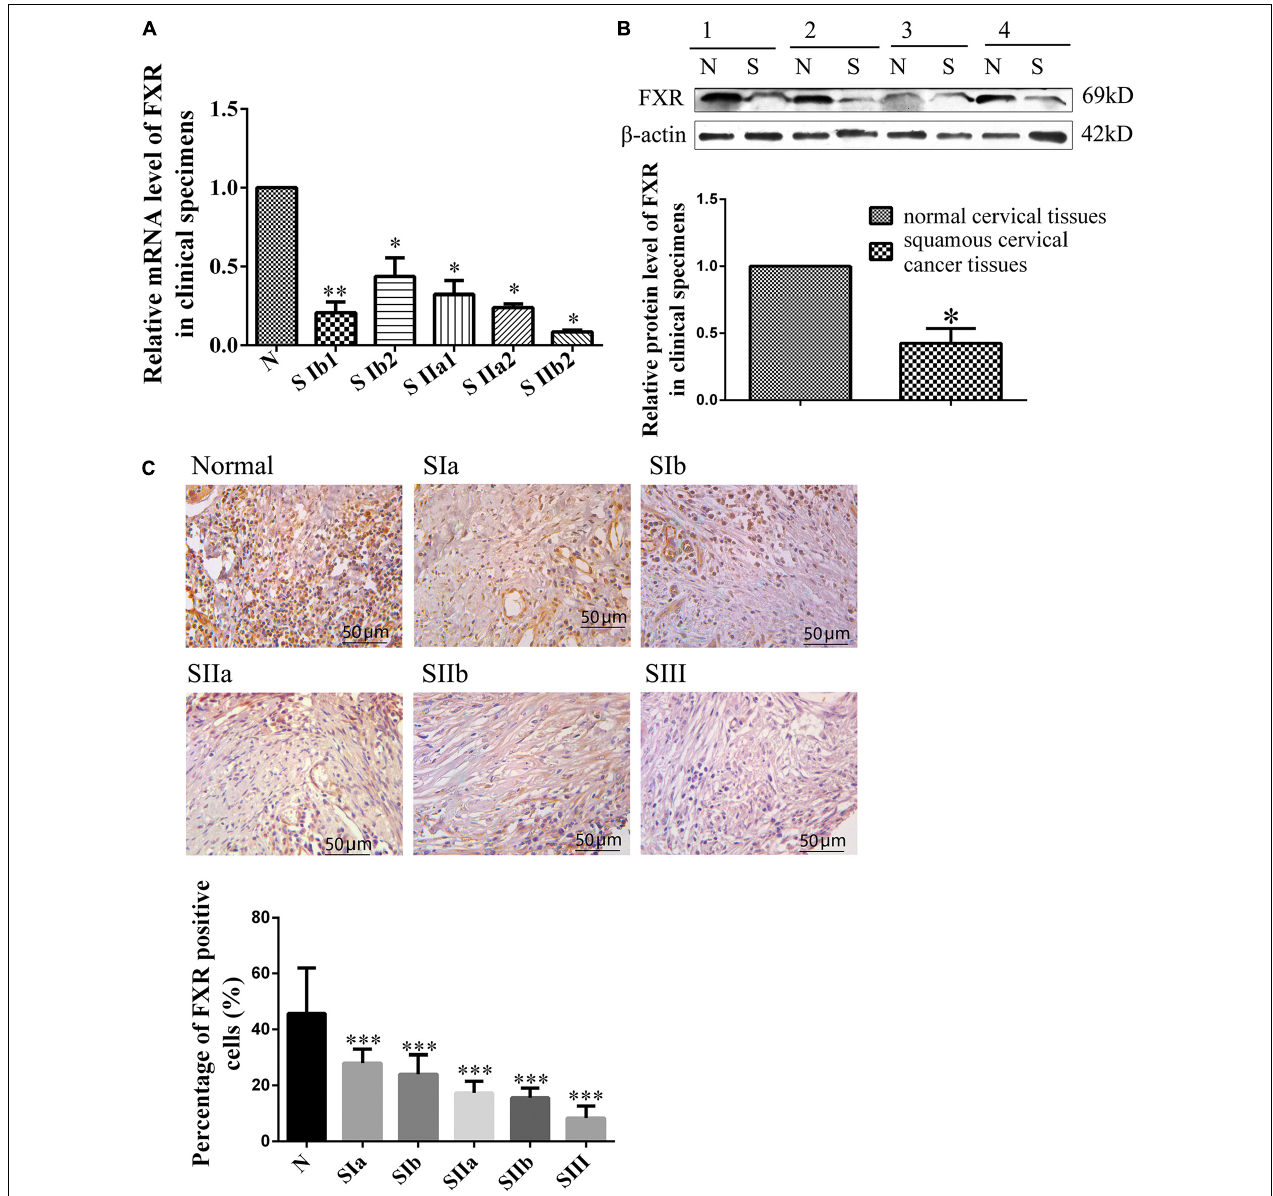
FIGURE 1 | FXR expression in human cervical cancer and non-cancerous tissues. Relative mRNA (A) and protein (B) levels of FXR in normal and squamous cervical cancer tissues. SIb1, SIb2, SIIa1, SIIa2, and SIIb2 are stages of squamous carcinoma; N represents normal cervical tissue. β -actin was used for normalization. Immunohistochemical staining (C) of a tissue microarray (normal and squamous cervical cancer tissues) for FXR. SIa, SIb, SIIa, SIIb, and SIII are stages of squamous carcinoma; N represents normal cervical tissue. Scale bar, 50 µ m. ∗ P < 0.05; ∗∗ P < 0.01; ∗∗∗ P < 0.001 vs. normal cervical